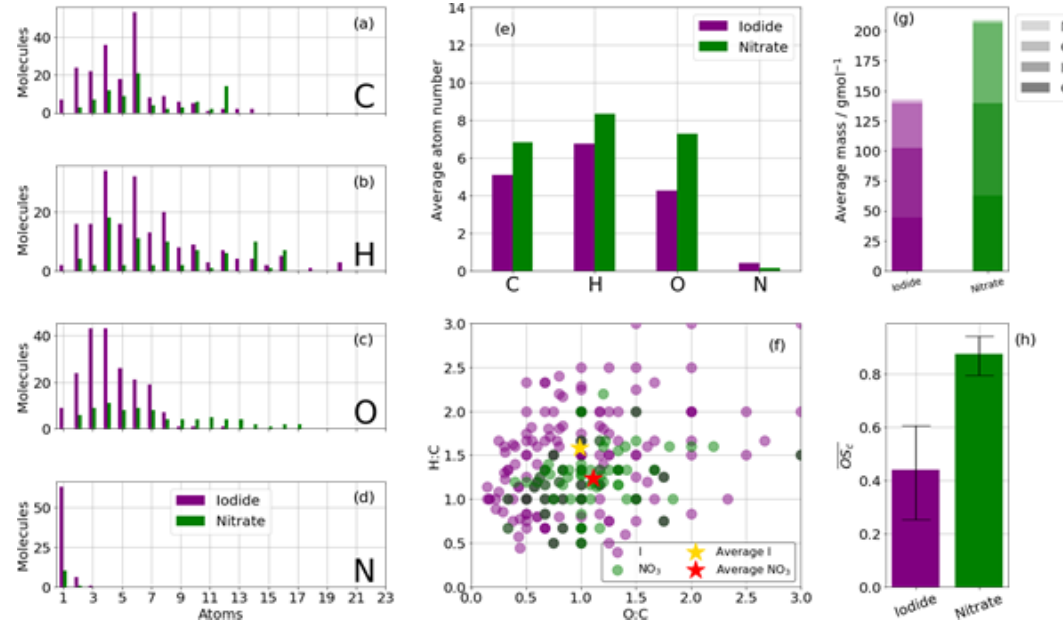
Figure 3. Summary of CHO and CHON statistics of detected oxidation products during the high-NO x (20ppb) benzene oxidation for iodide (purple) and nitrate (green) ionisation schemes. (a, b, c, d) Frequency distributions of the atoms C, H, O, and N for the detected oxidation products. (e) Average number of atoms per detected oxidation product split into C, H, O, and N. (f) Van Krevelen diagram (O : C vs. H : C). (g) The average mass of a detected oxidation product detected by iodide and nitrate ionisation. (h) The average carbon oxidation state OS C of oxidation products detected by iodide and nitrate ionisation. Limits represent minimum and maximum OS C as a function of minimum and maximum OS N ; see Sect. 2.3.